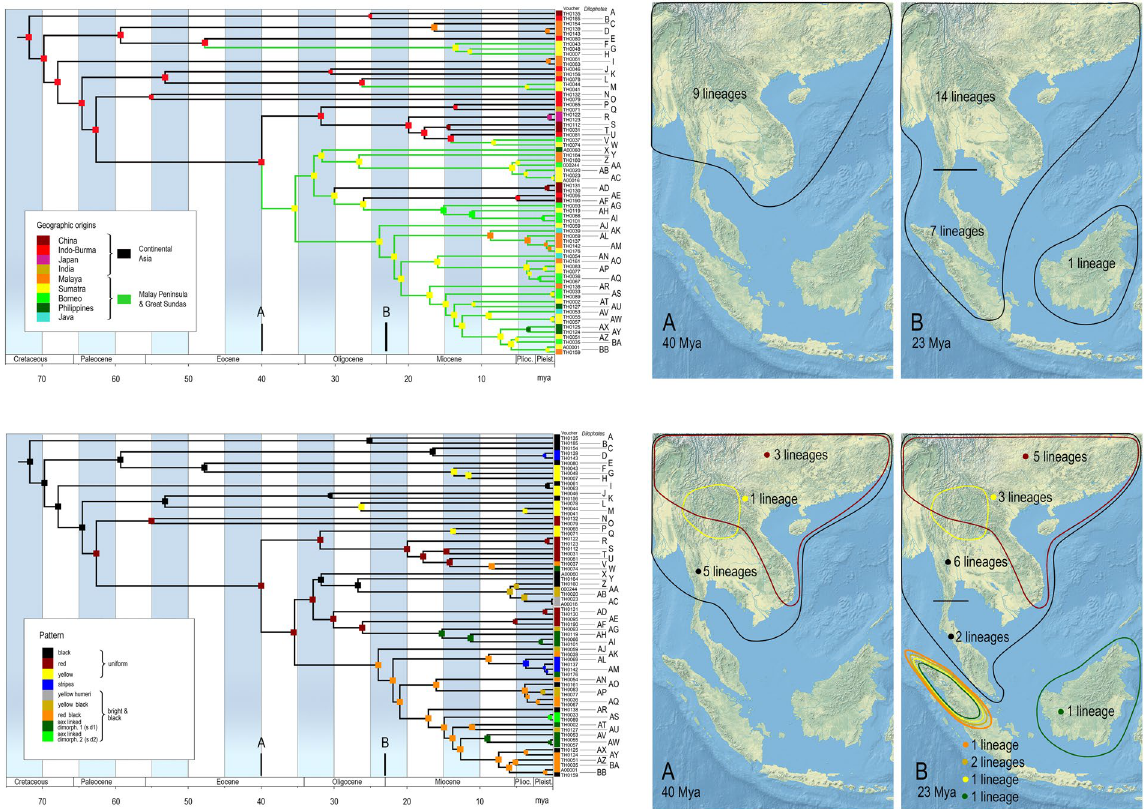
Figure 5. ( A ) Distribution of Dilophotes in the Upper Eocene and at the Oligocene/Miocene boundary; ( B ) Presence and distribution of aposematic patterns in the Upper Eocene and at the Oligocene/Miocene boundary. The map was downloaded from Natural Earth server (http://www.naturalearthdata.com) and edited using Adobe Photoshop CS6